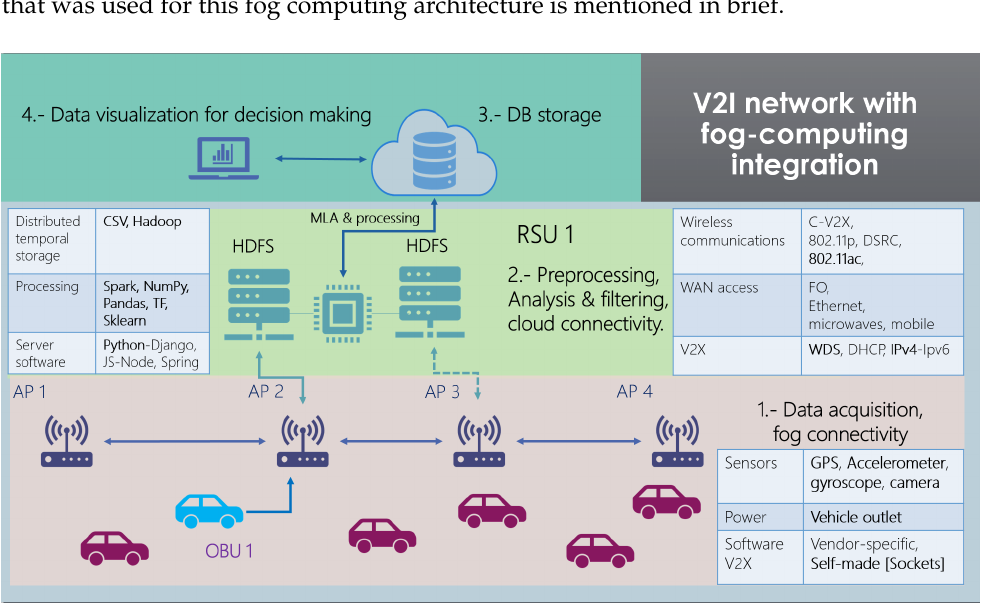
Figure 3. Fog Computing—V2I network proposed solution for Anomaly